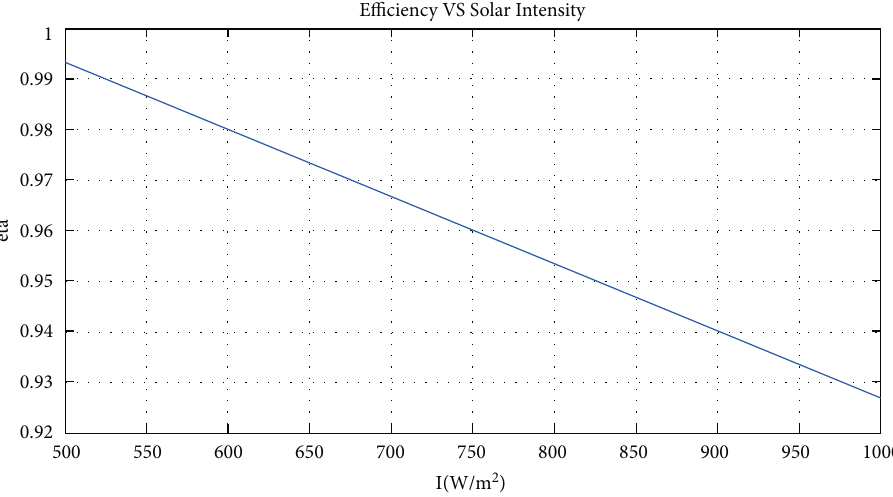
Figure 7: Changes in the e ffi ciency of the absorber pipe by the intensity of radiation.